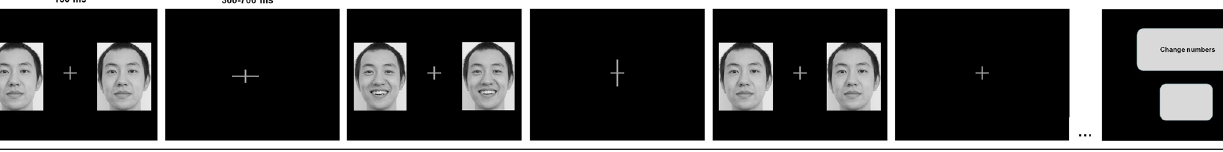
Fig 1. Sample stimuli and experimental procedure for one experimental block in the happy oddball condition. Two identical facial expressions were displayed bilaterally to both sides of the central fixation cross. The presentation of faces and the changes of the fixation cross were independent. The face- pair was presented on each screen for 150ms, followed by an inter-stimulus interval of 300 – 700 ms. The cross changed occasionally during each block, and participants were required to detect the changes and to report at the end of each block how many times the cross had